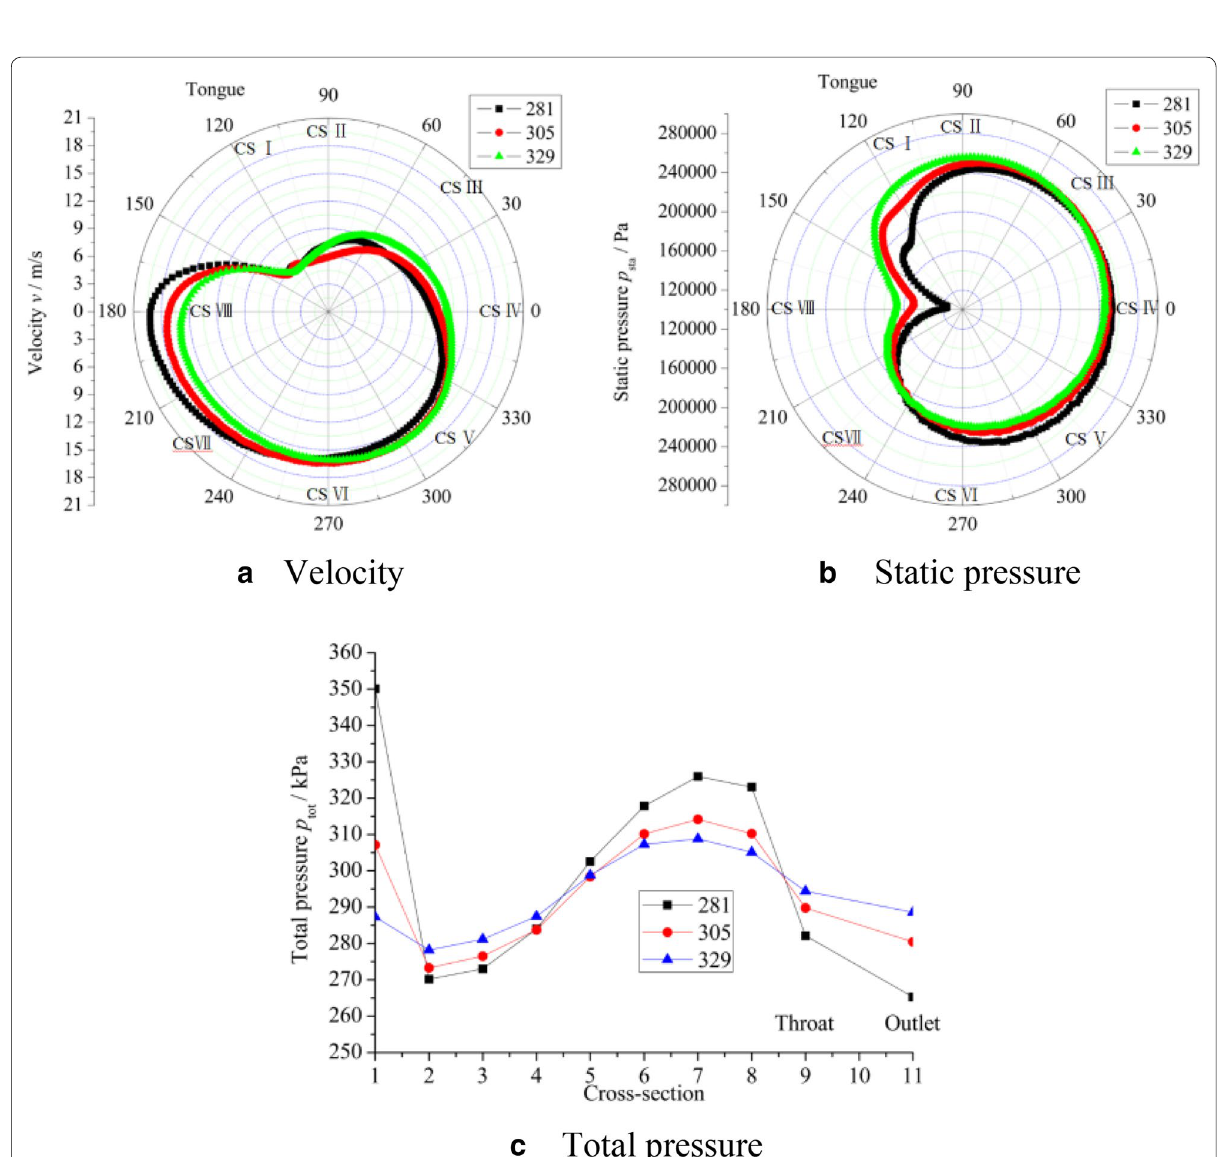
Figure 12 Distribution of pressure and velocity in volute casing at flow rate of 170 m 3